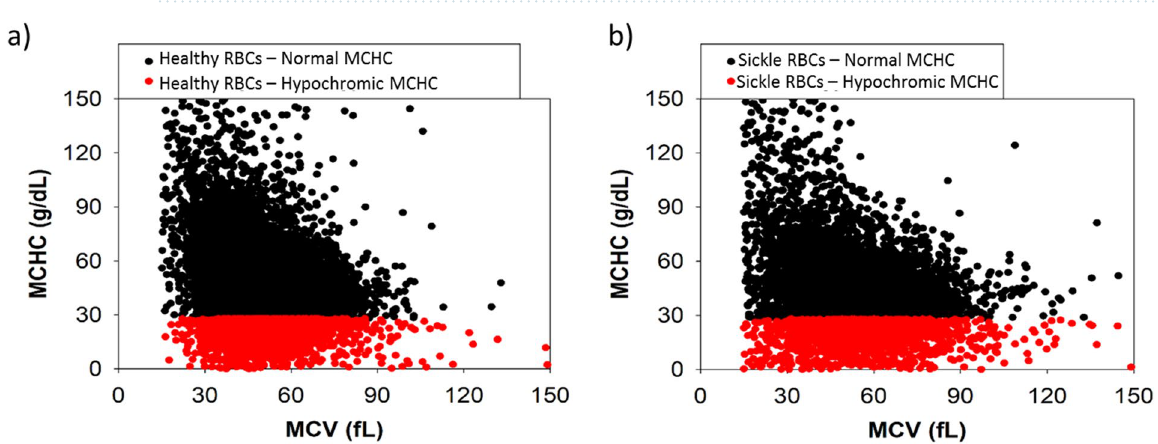
Figure 5. MCHC CTV and MCV CTV calculations for ( a ) all healthy RBCs and ( b ) sickle RBCs. Normal (black) cells and hypochromic (red) cells are shown with the cutoff value of 28